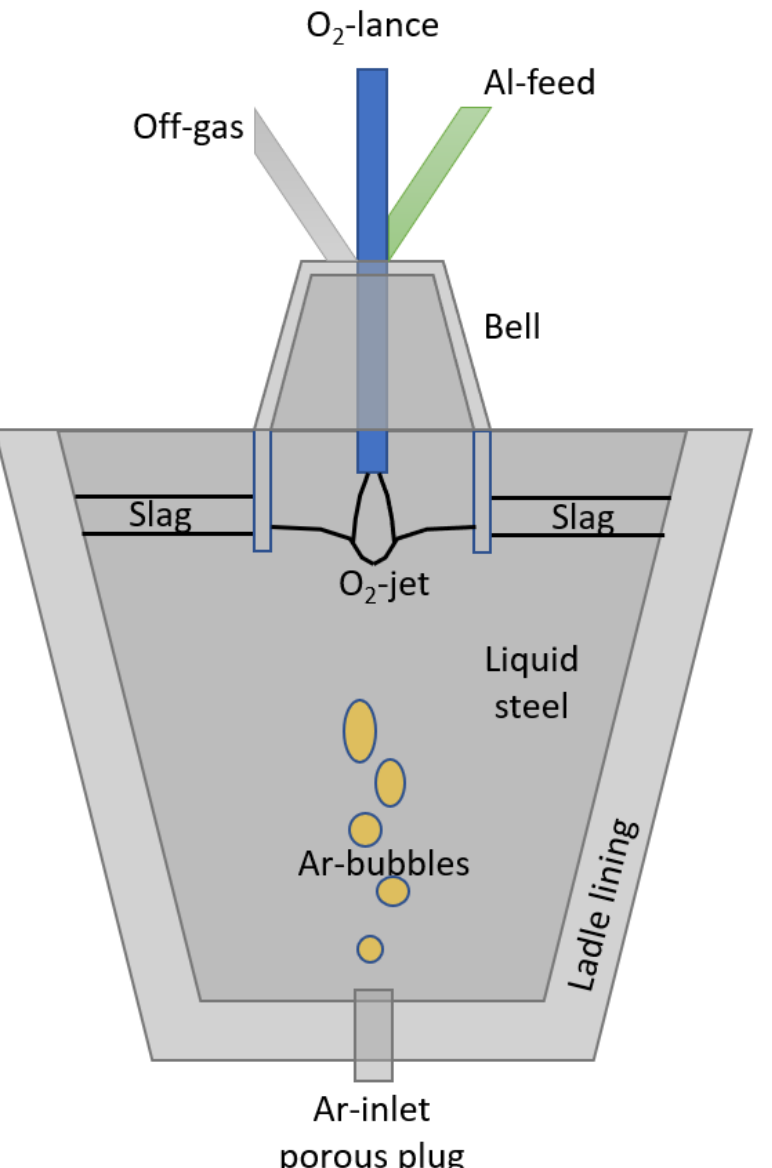
Figure 1. Illustration of the CAS-OB